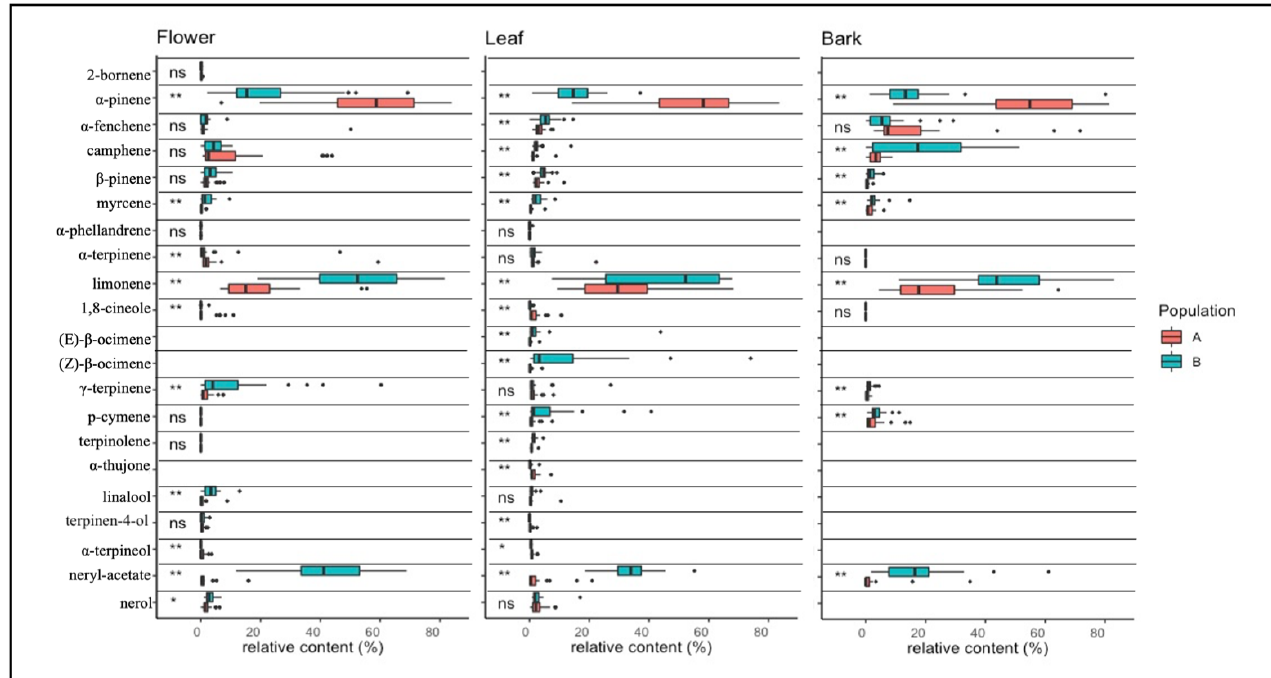
Figure 4. Boxplot and ANOVA of monoterpenes in flower, bark, and leaf tissues. Significance ANOVA code are: (ns) for p > 0.05; (*) for 0.05 < p > 0.01; and (**) for p < 0.01. H. litoreum is reported in population A, and H. italicum subsp. italicum in population B.